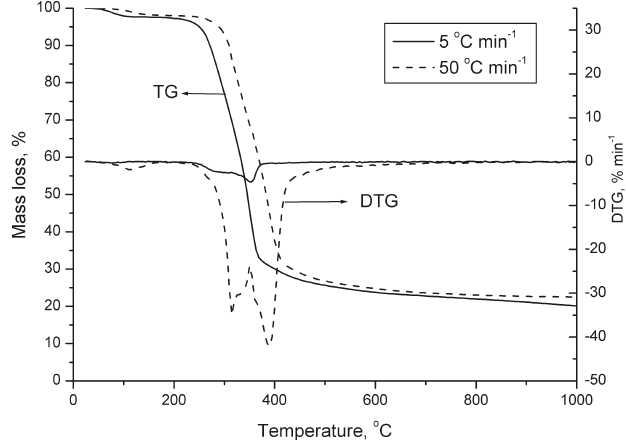
Figure 3. Thermogram of birch wood obtained with heating rates 5 and 50°C min -1 . Table 2. Thermogravimetric parameters of the plant material pyrolysis. Wood species